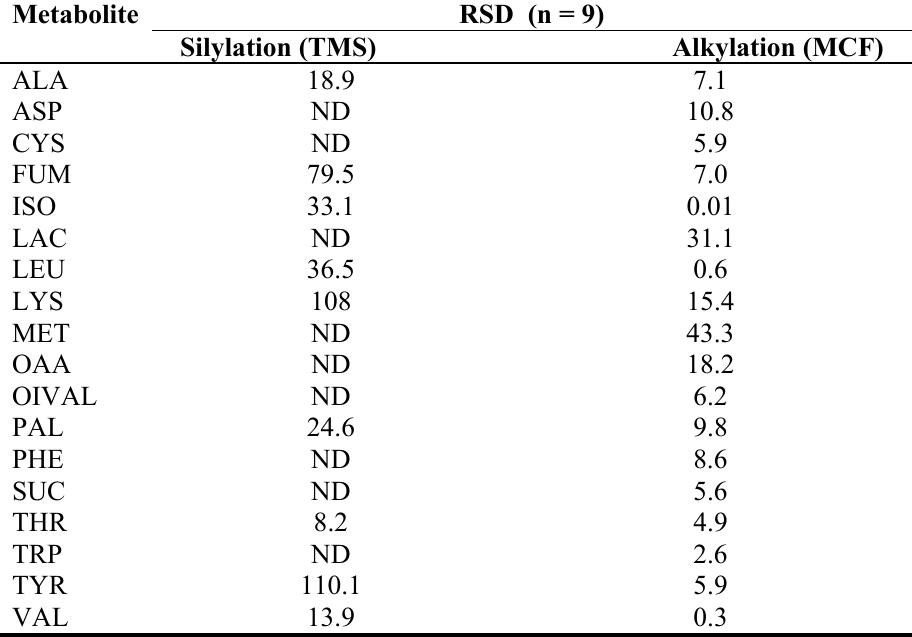
Table 5. Some metabolites detected in the spent culture medium of Acidovorax temperans and their respective repeatability